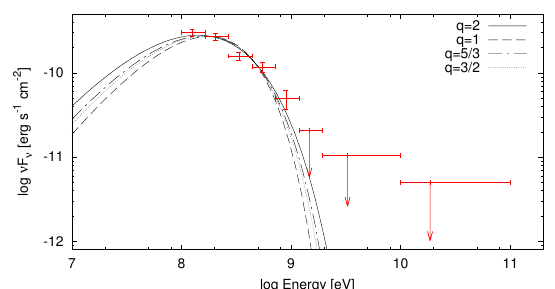
Figure 1: Inverse Compton spectrum formed by a modified Maxwellian electron distribution fitted to the post-periastron Fermi flare